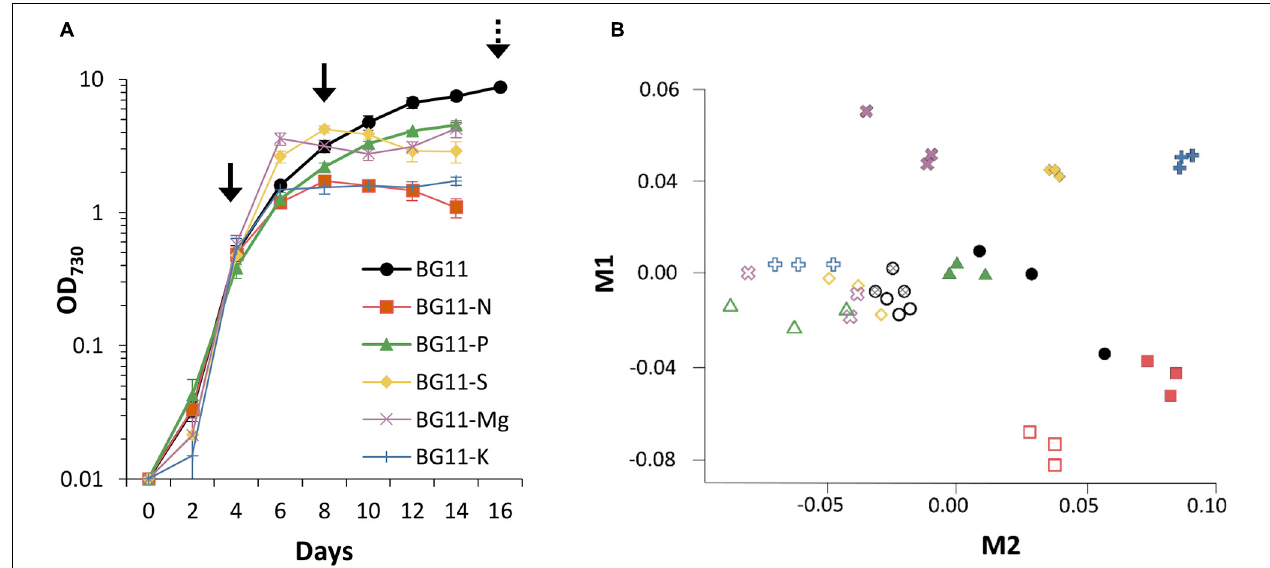
FIGURE 2 | Growth and transcriptomics of Synechocystis sp. PCC 6803. (A) Culture density (OD 730 ) of Synechocystis batch cultures cultivated under control (BG11) and low nutrient conditions (12.5% N, P, S, Mg, or K in BG11 background, Supplementary Table S1 ). Solid arrows show when samples were collected for RNA sequencing from all conditions. Dashed arrow indicates additional samples collected from control conditions. Data are means ± S.E.M. of three independent cultures. (B) Multi-dimensional scaling plot of 39 RNAseq expression profiles. Distances between points reflect relative similarities between samples based on genome-wide transcript levels. Symbols and colours are same as in (A) . Open symbols represent early growth phase samples (day 4). Closed symbols represent late growth phase samples (day 8 in low nutrient and day 16 in control conditions). Hatched circles represent control samples harvested on day